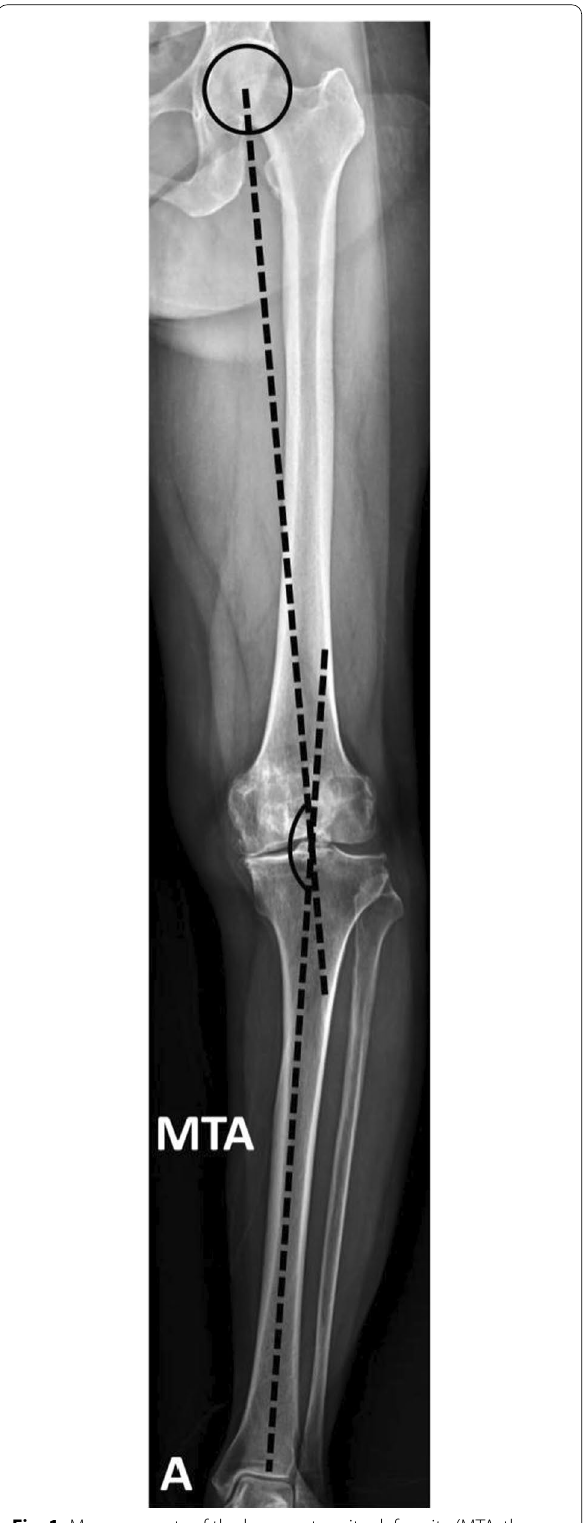
Fig. 1 Measurements of the lower extremity deformity (MTA, the angle between the mechanical femoral and tibial